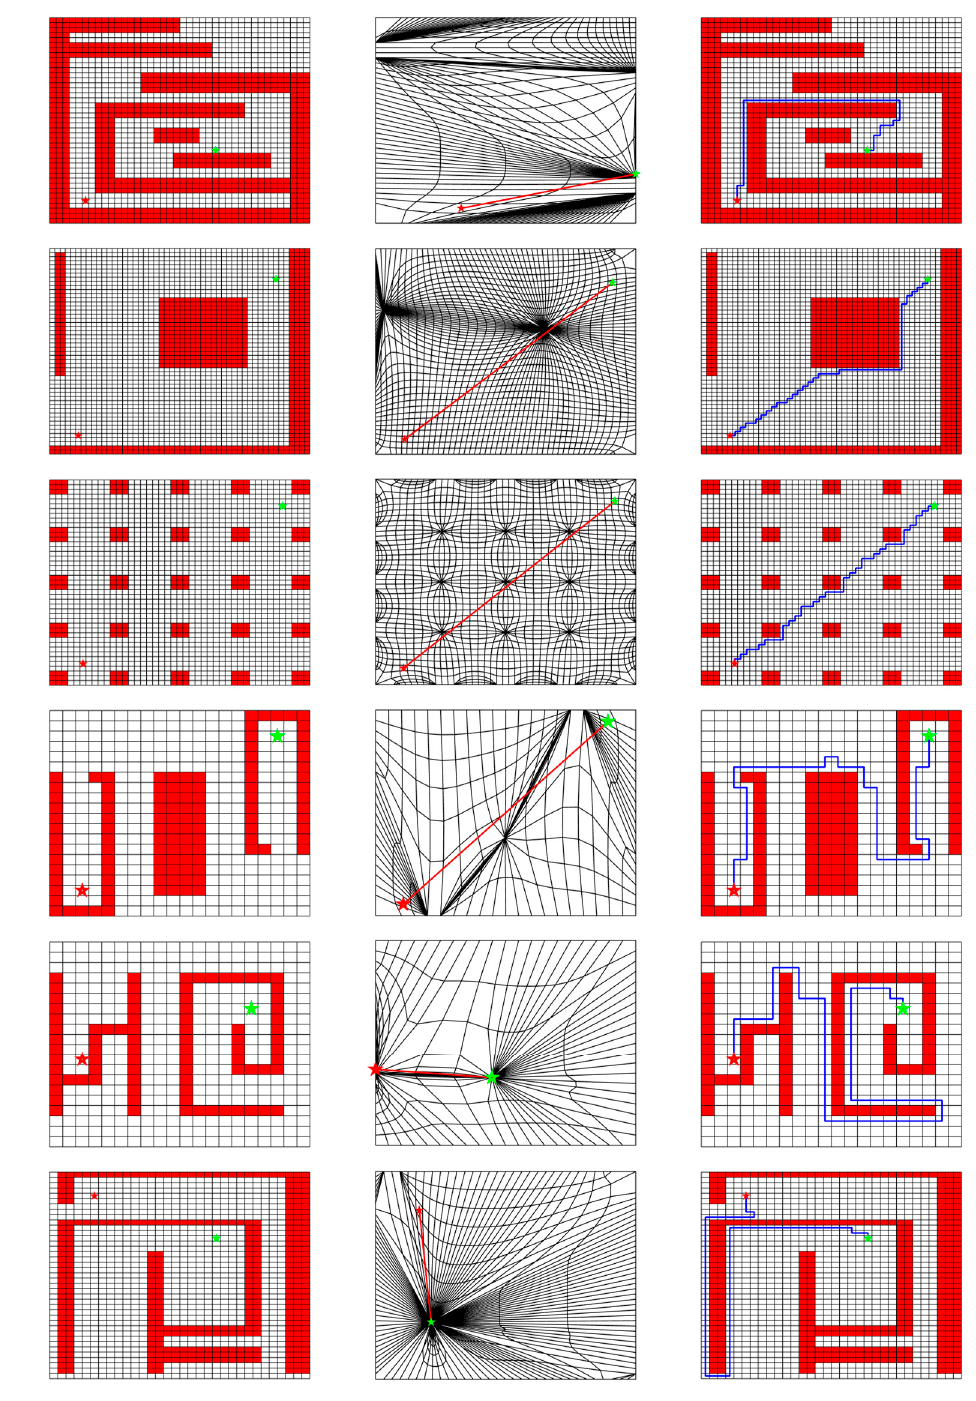
Figure 11. The examples of C-space with mixed types of obstacles. The first column is the initial C- space. The second column is the generated DC-space with the ACPG and NGA methods. The start position (red star) and the target position (green star) are connected with the red line. The third column is the generated path after projecting the path back to the